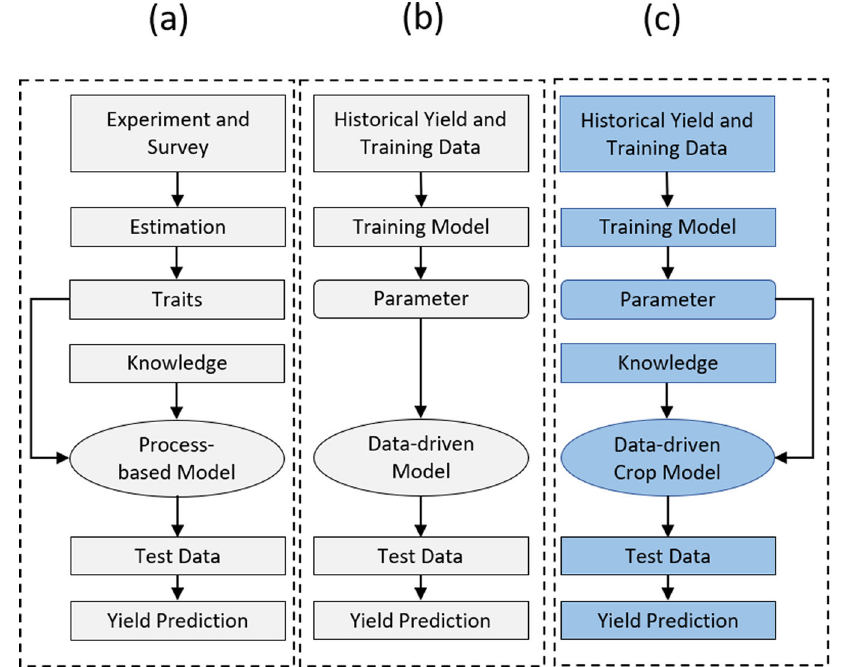
Fig. 1 Comparison of process-based, data-driven, and the proposed data-driven crop models. a Process-based models are built with human knowledge on plant physiology with explicit assumptions about genotype by environment interactions; numerous traits (modeling parameters) need to be estimated using experiments or survey of the literature. b Data-driven models rely on historical data to approximate the complex relationship between input and output. c The proposed Data-driven Crop model combines the strengths of two types of models.